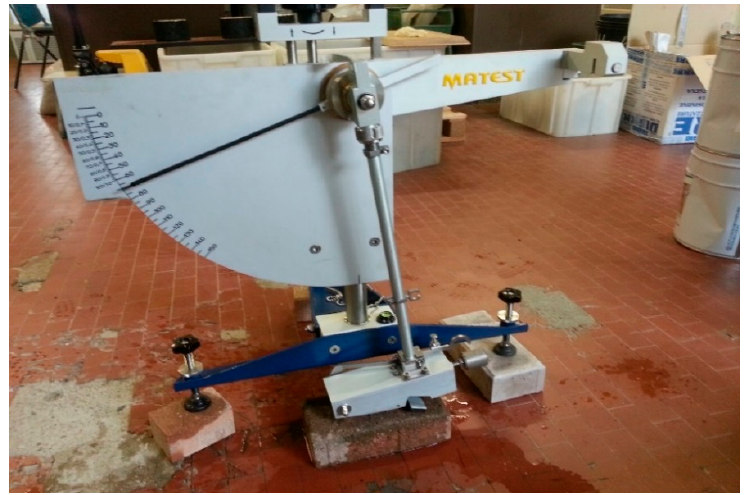
Figure 4. Pendulum friction tester during the skid resistance tests on concrete paving blocks.